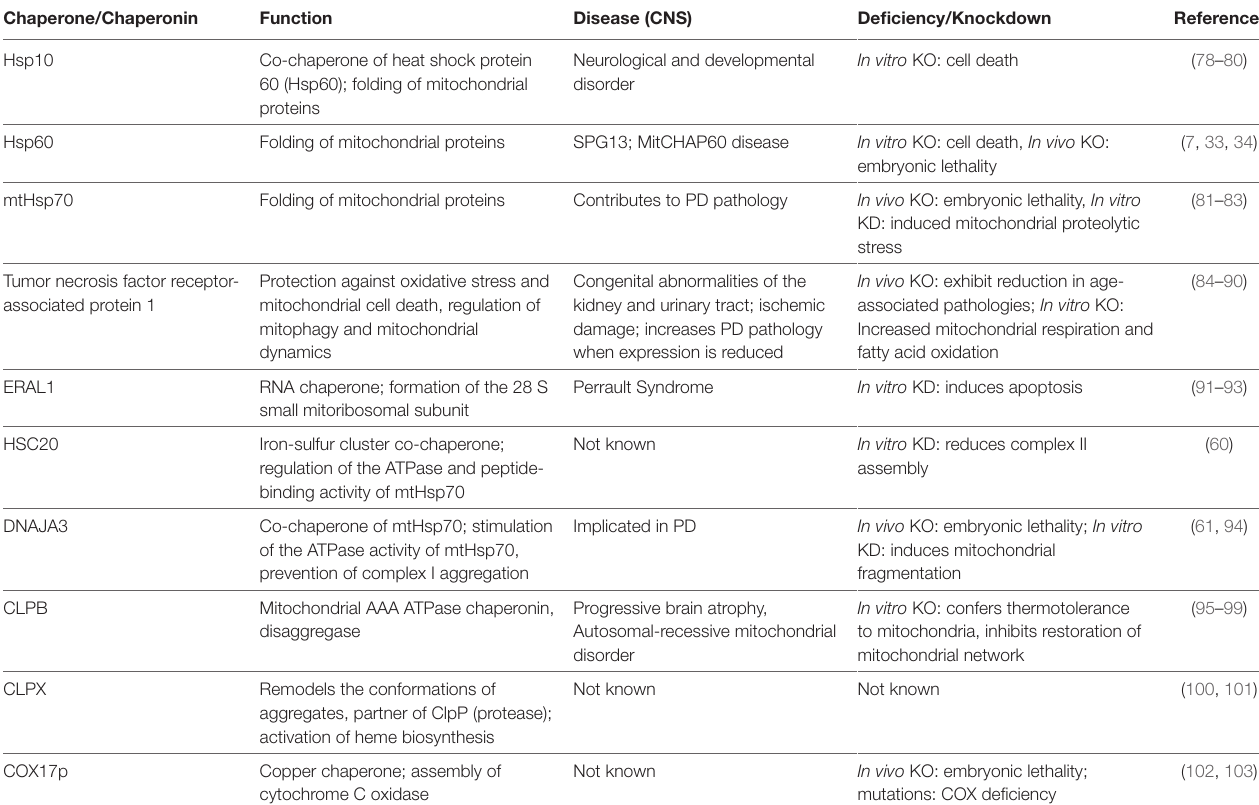
taBLe 1 | Chaperones and mitochondrial dysregulation in neurodegenerative and metabolic disease(s).